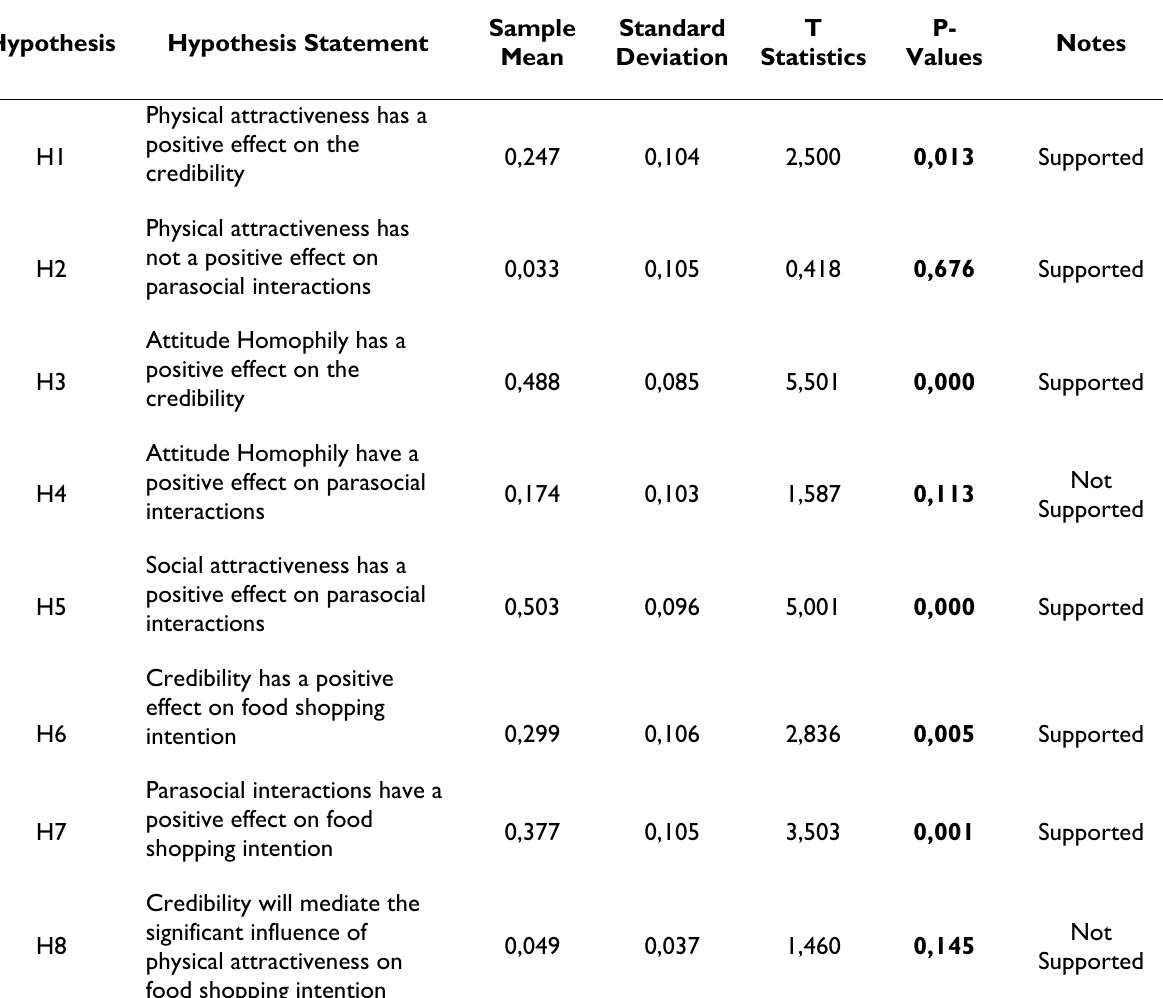
Table 3. Hypothesis Test Result